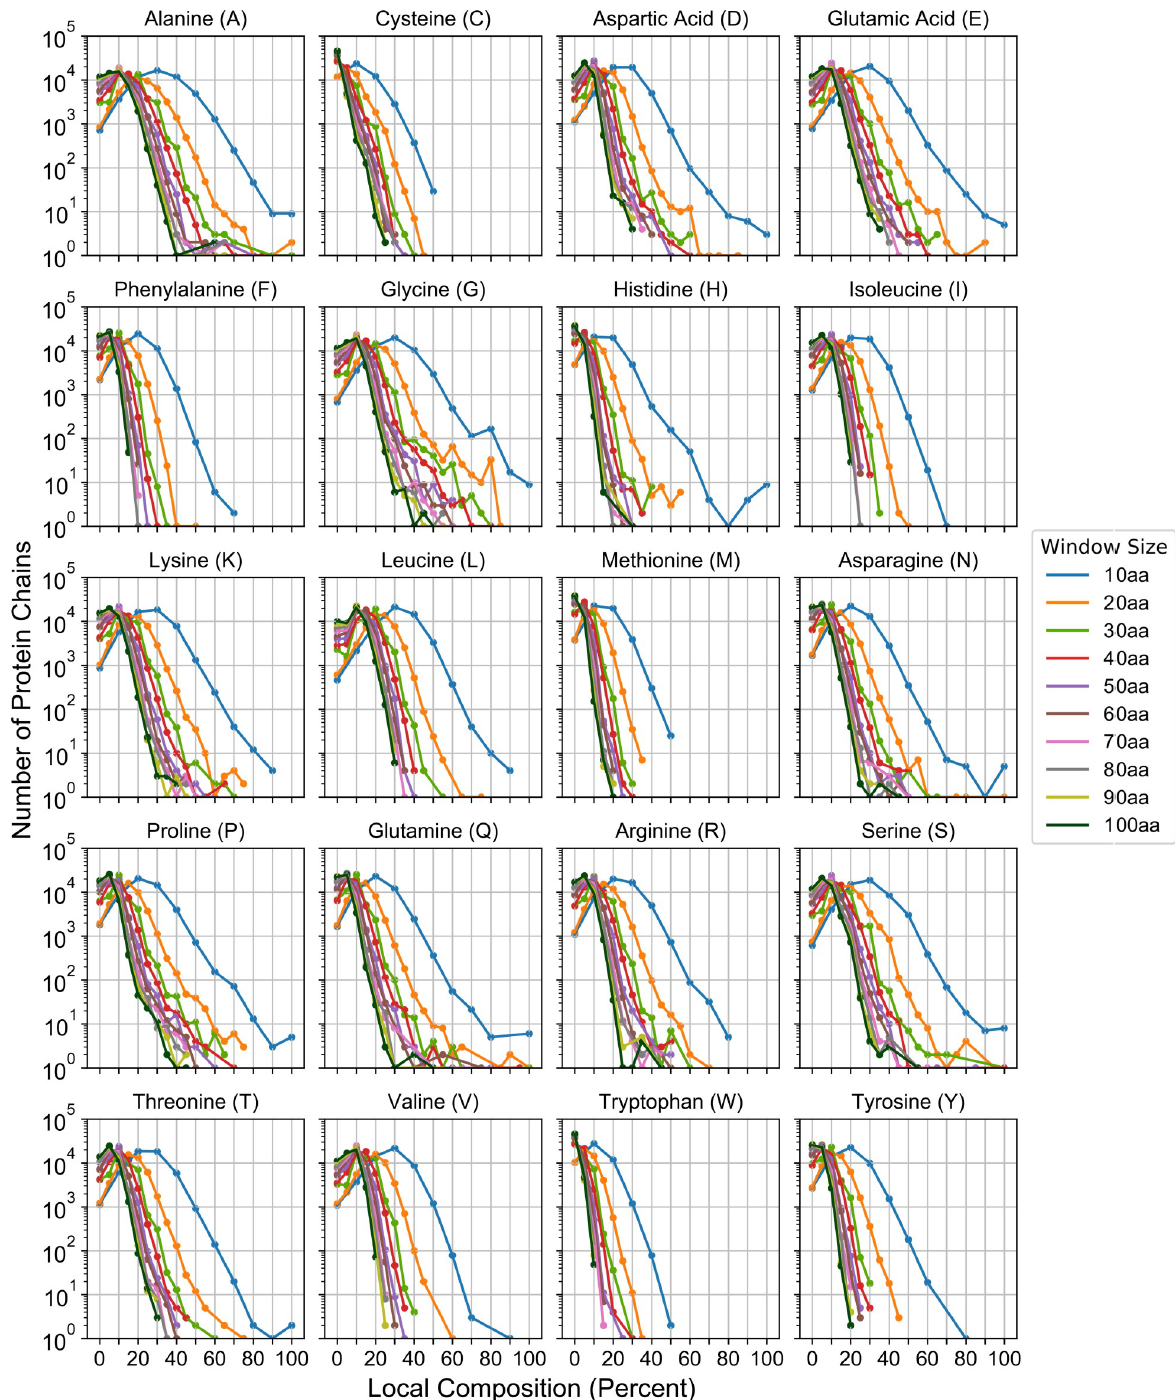
Fig 1. LCDs are abundant in structured proteins. Each subplot indicates the frequency distributions for all peptide subsequences within PDB proteins as a function of scanning window size and amino acid composition for each amino acid indicated in the subplot